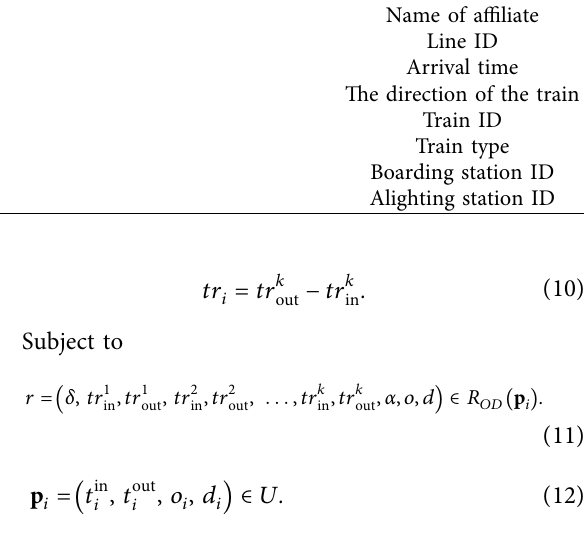
Table 1: Description of the smart card data. No.